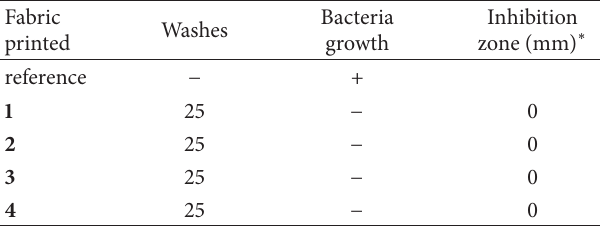
Table 3: Antibacterial features of